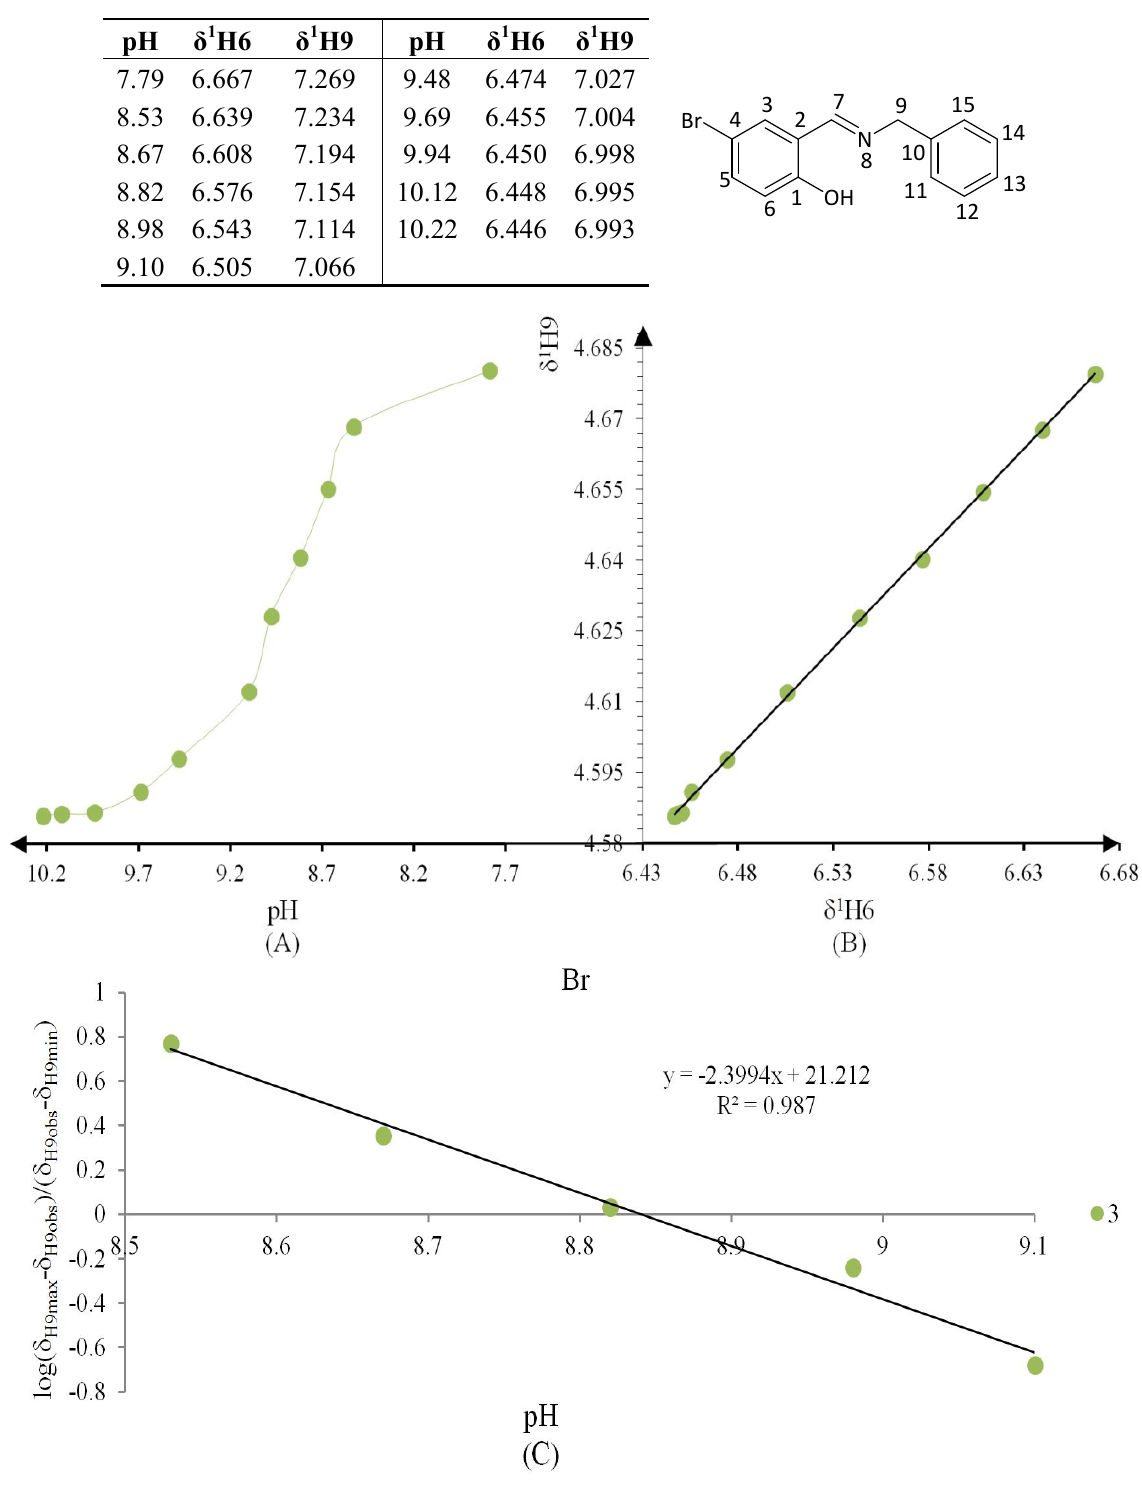
Figure 8. ( A ) titration curve (pH vs. δ 1 H9); ( B ) δ -diagram with Perrin model analysis ( δ 1 H6 vs. δ 1 H9) and ( C ) plot of the semilogarithmic Henderson-Hasselbalch equation (pH vs. log[( δ − δ )/( δ − δ )]) of compound 3 (R = H9max H9obs H9obs H9min